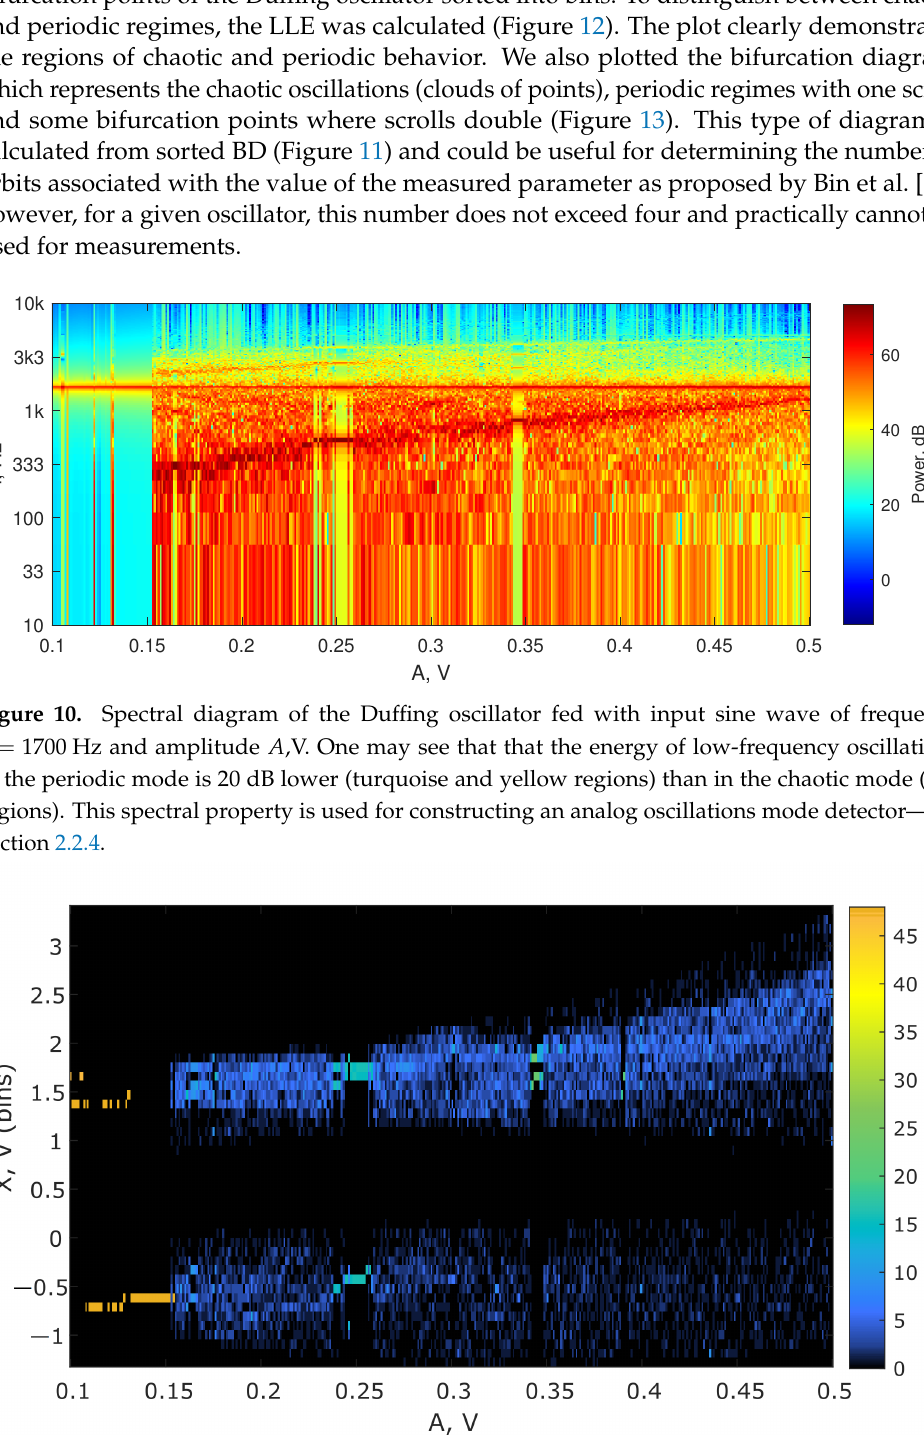
Figure 11. Bifurcation diagram of the Duffing oscillator with points sorted into bins. The field of the diagram is a matrix of bins of size M × N, where M is the specified number of bins, and N is the number of parameter A values. Points of a bifurcation diagram in the bins are